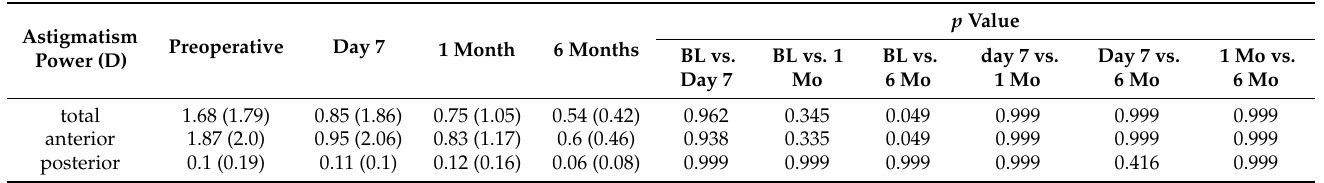
Table 4. Analysis of astigmatism asymmetry in central 6-millimeter zone in eyes with pterygium removal by autologous conjunctival autograft with human fibrin tissue